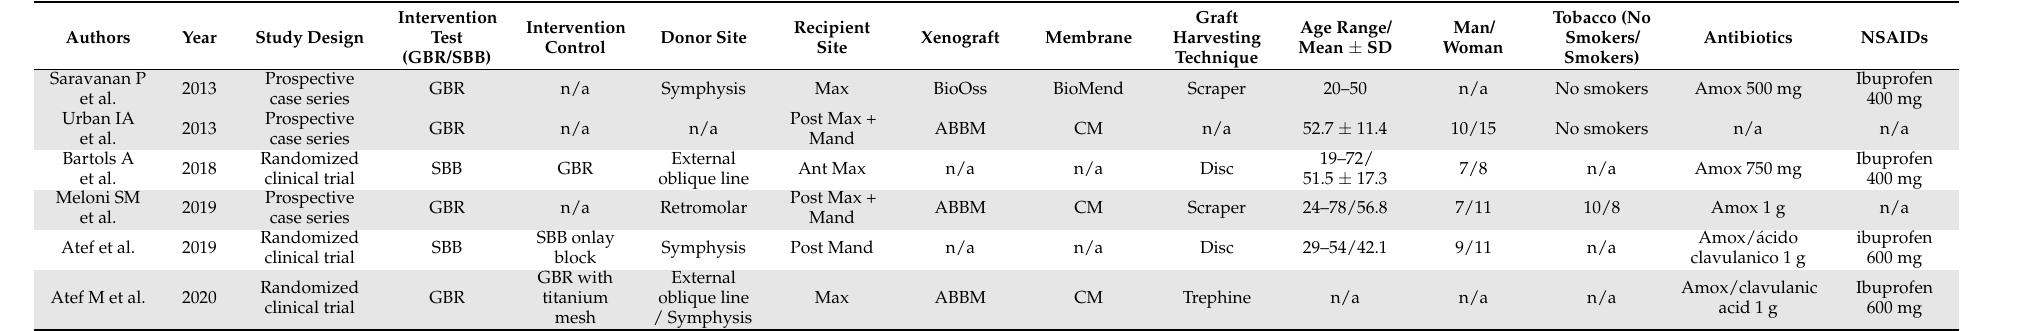
Table 2. Sample and study characteristics. PCS: Prospective case series; RCT: Randomized controlled clinical trial; GBR: Guided bone regeneration; SBB: Split bone block; Max: Maxilla; Mand: Mandible; Ant: Anterior; Post: Posterior; ABBM: anorganic bovine bone mineral; n/a: Non-applicable. (Grey lines correspond to Urban procedures and white lines to Khoury).